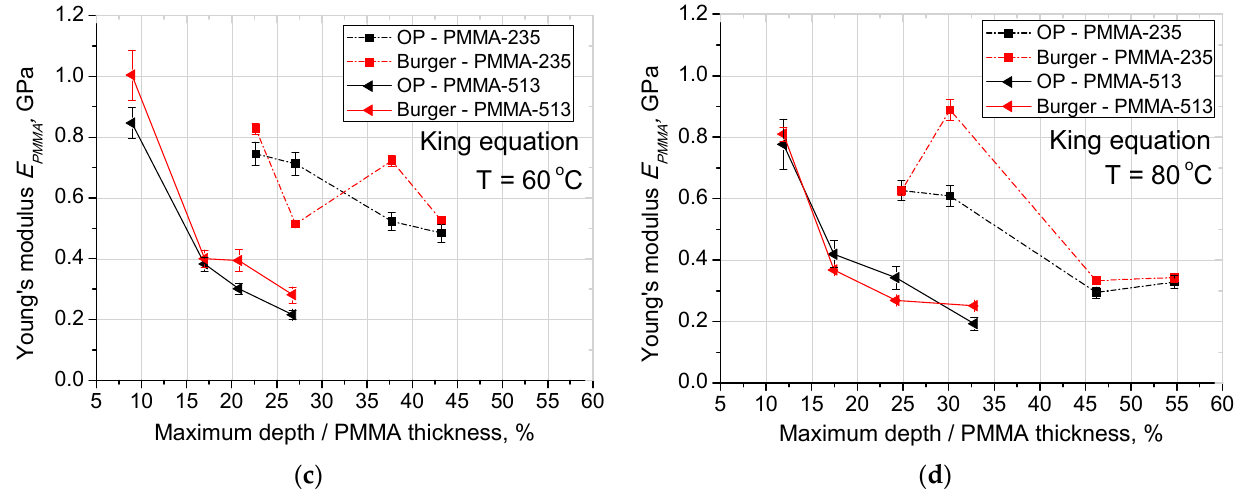
Figure 5. Analysis of PMMA Young’s Modulus after King’s correction for thin films; obtained by: Oliver and Pharr, Burger model, ( a ) modulus at 20 °C; ( b ) modulus at 40 °C; ( c ) modulus at 60 °C, ( d ) modulus at 80 °C. Lines are just guides for the eyes.